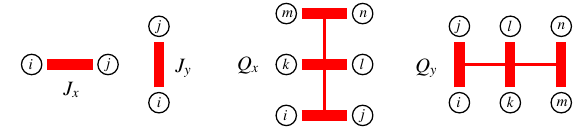
FIG. 1. Illustration of the terms of the J - Q model used in this work. The circles are sites on the square lattice labeled in accordance with the Hamiltonian Eq. (1). The red bars connecting the two sites are the singlet projectors, and the connected bars in the Q terms indicate